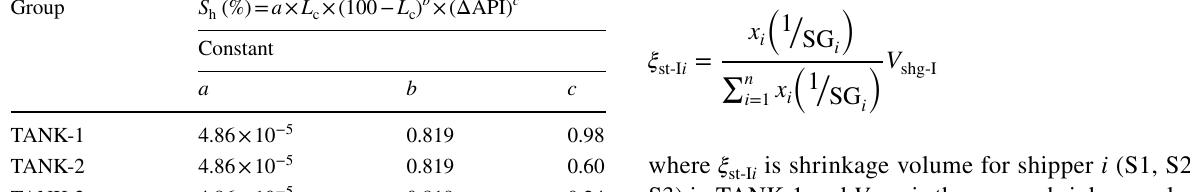
Table 8 Parameters a , b , c in API 12.3 equations